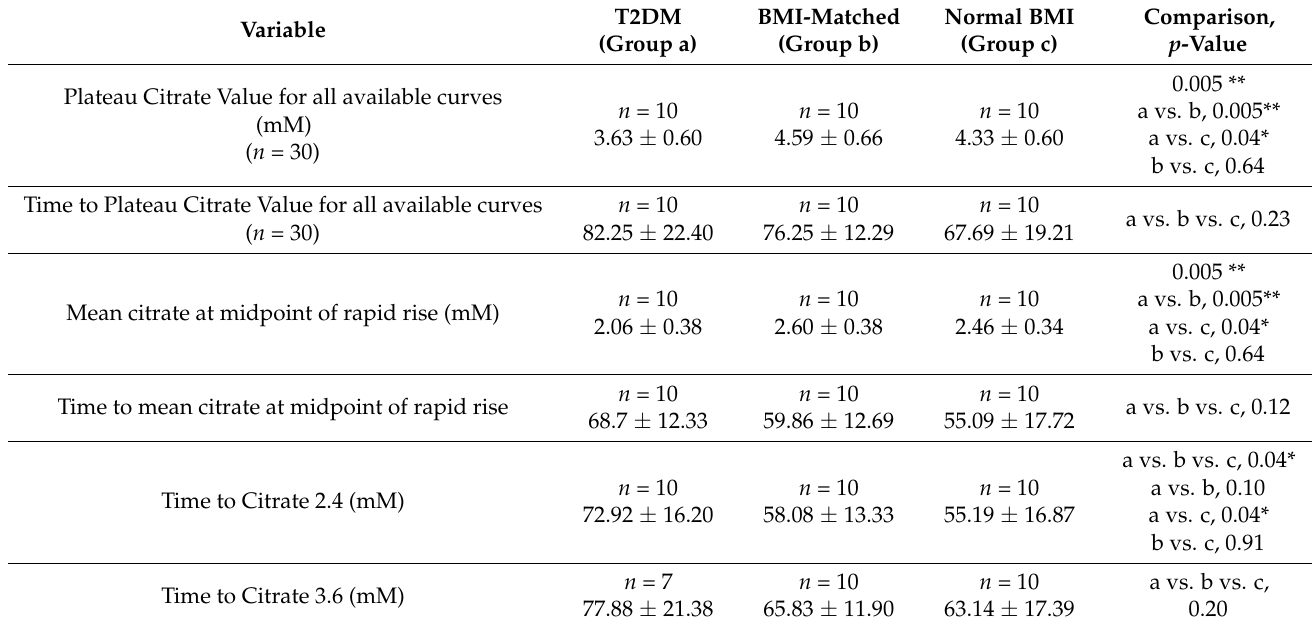
Table 3. Breastmilk Citrate Concentrations